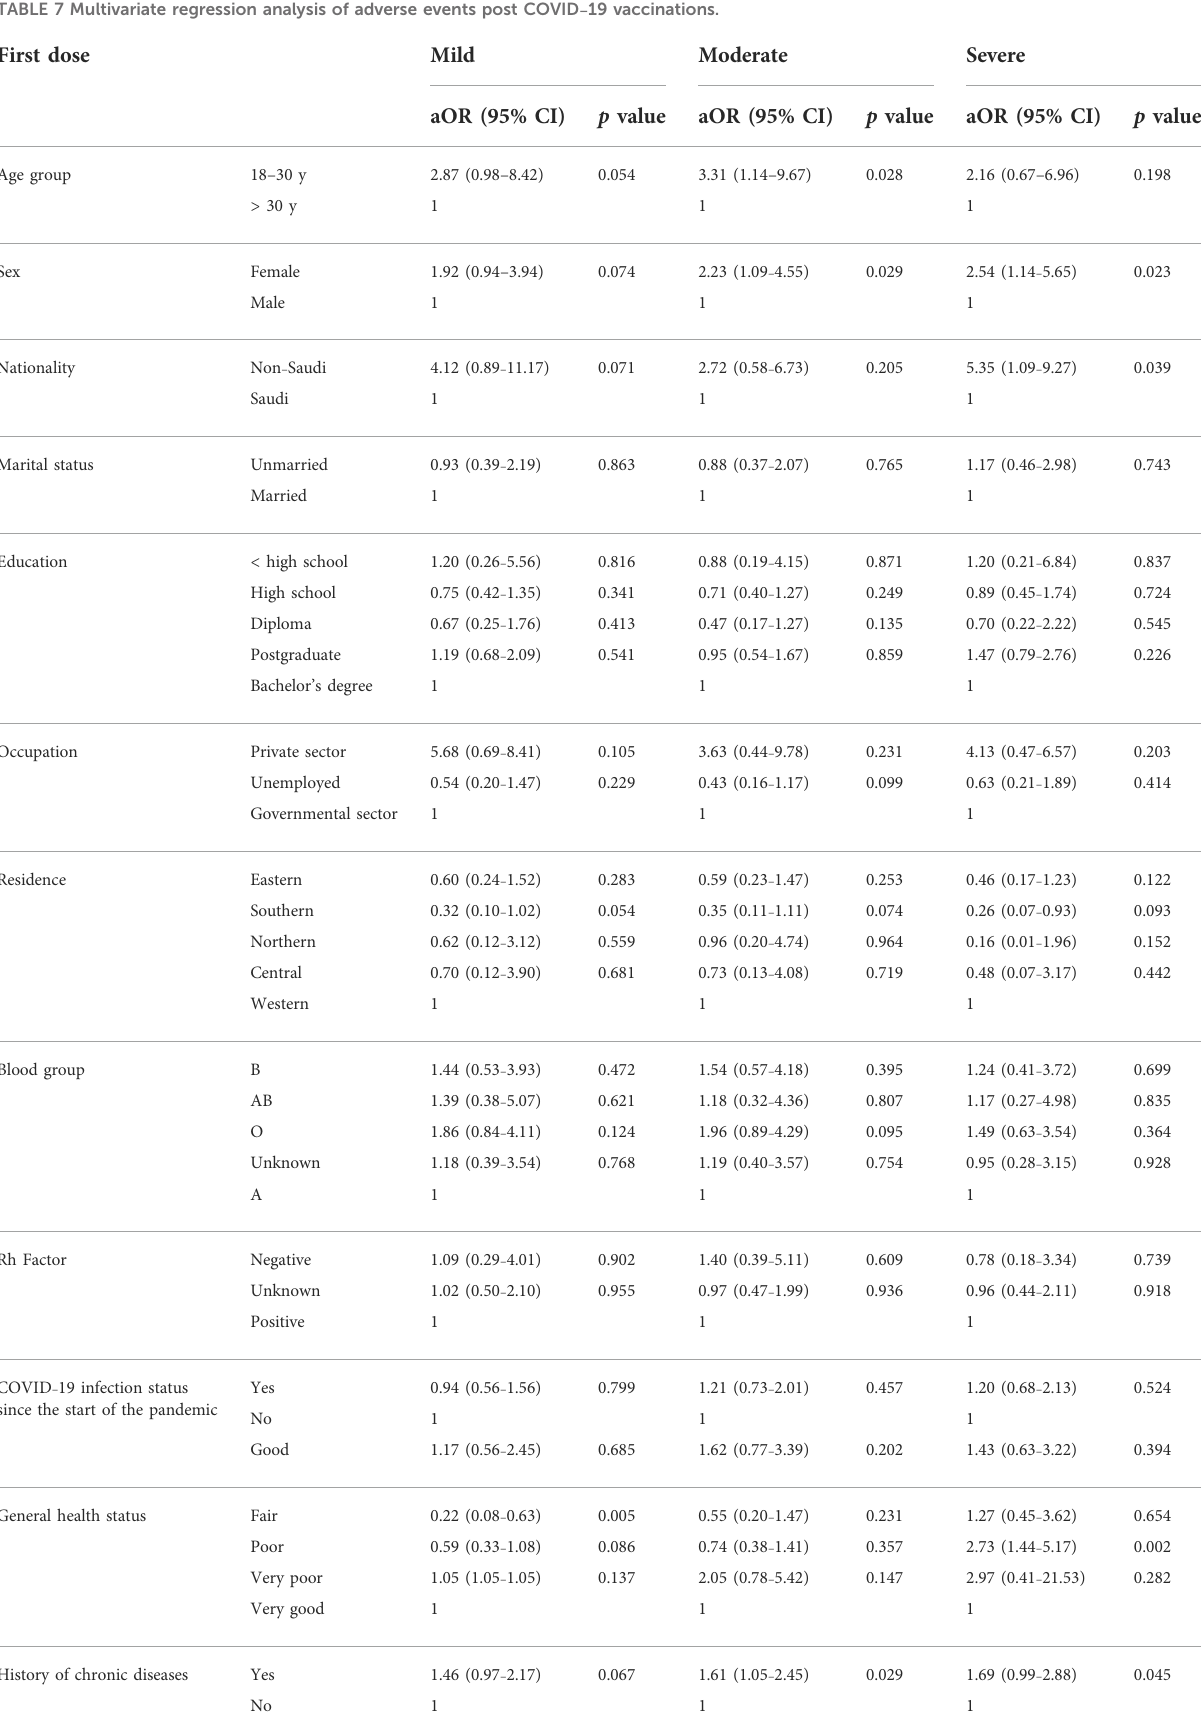
TABLE 7 Multivariate regression analysis of adverse events post COVID – 19